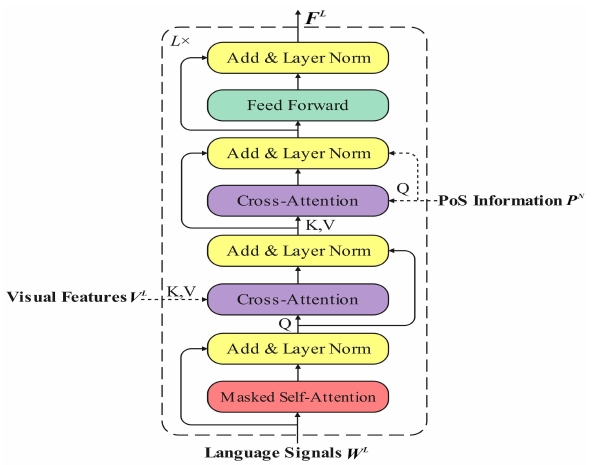
Figure 3. The structure of the single-attention-based multimodal decoder model with part-of- speech